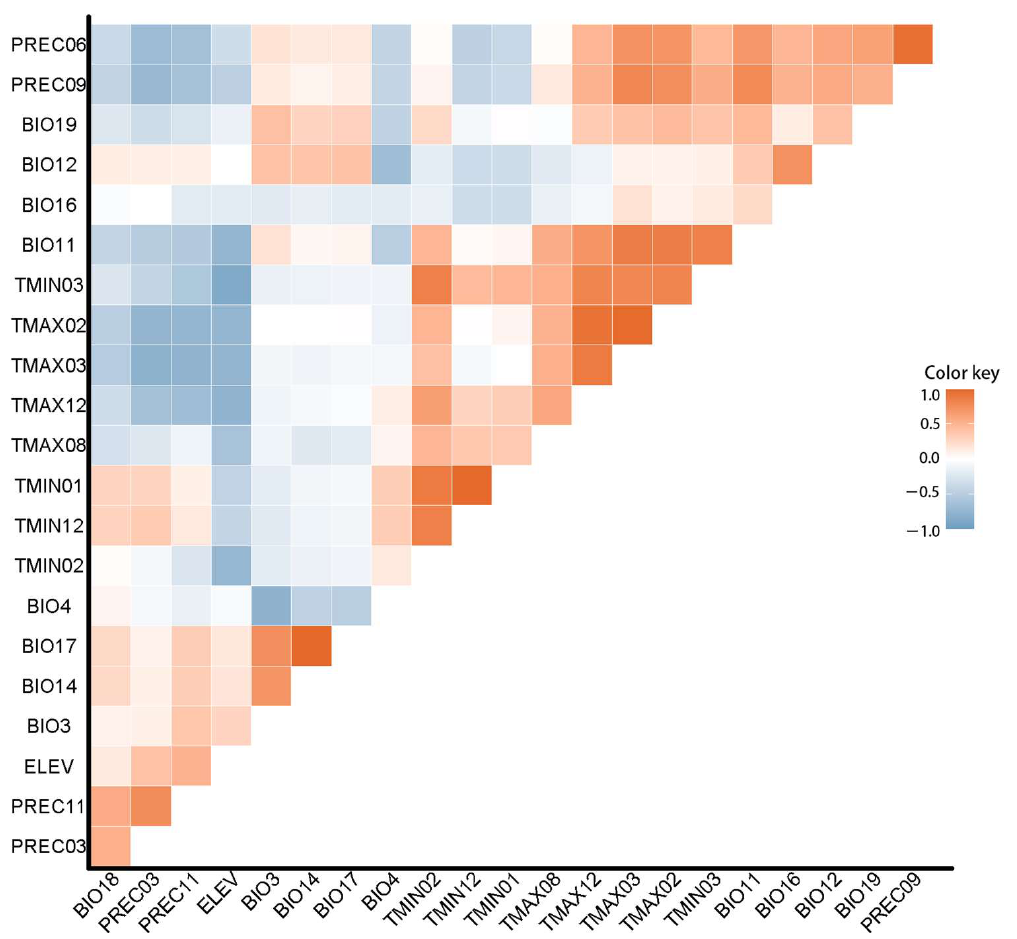
Figure 2. Heat map of Pearson’s correlation coefficient.